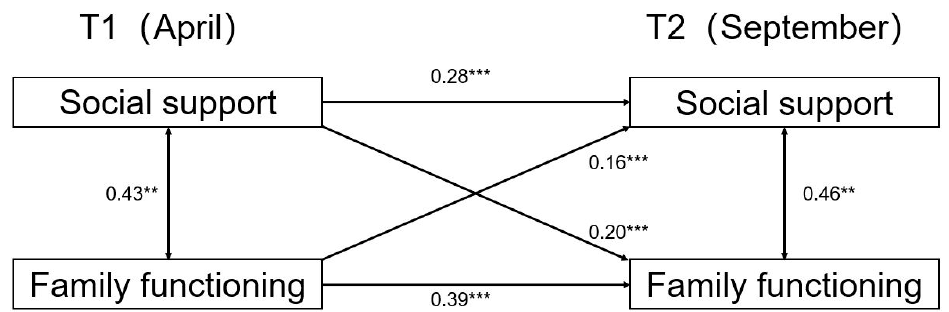
Figure 2. Cross-lagged model for social support and family functioning for girls. Note: statistically significant standardized path coefficients are shown with solid lines. ** p < 0.01. *** p <